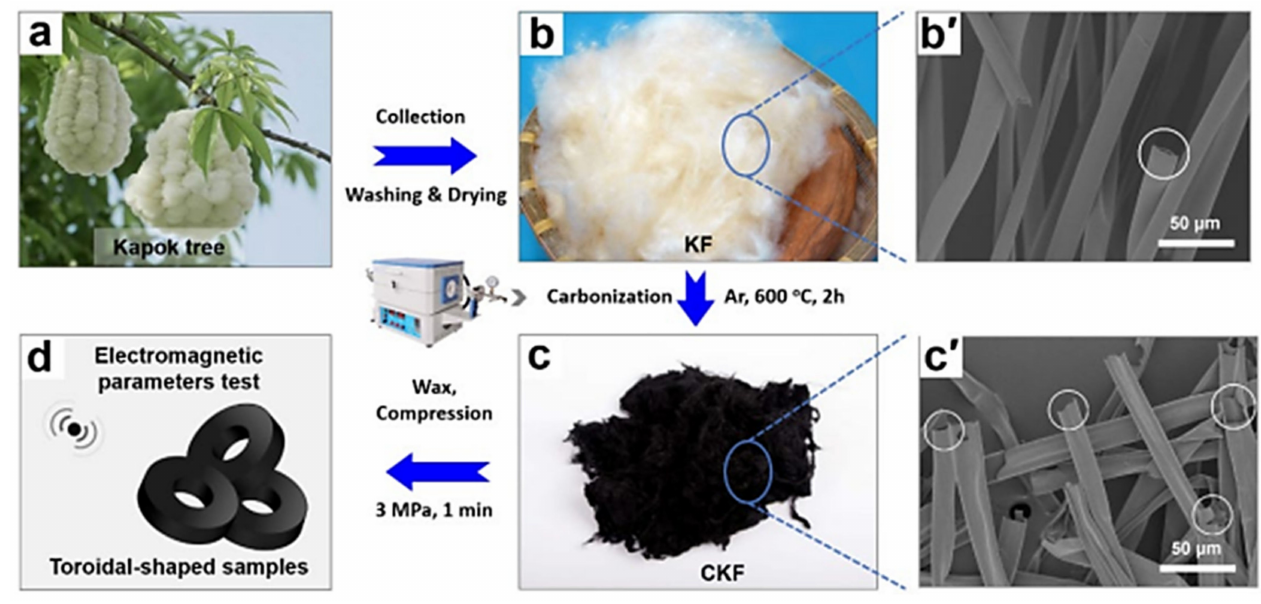
Figure 3. Synthesis process ( a – d ) and microscopic morphology of kapok fiber microtubes: uncar- bonized ( b’ ) and carbonized ( c’ ) [56].